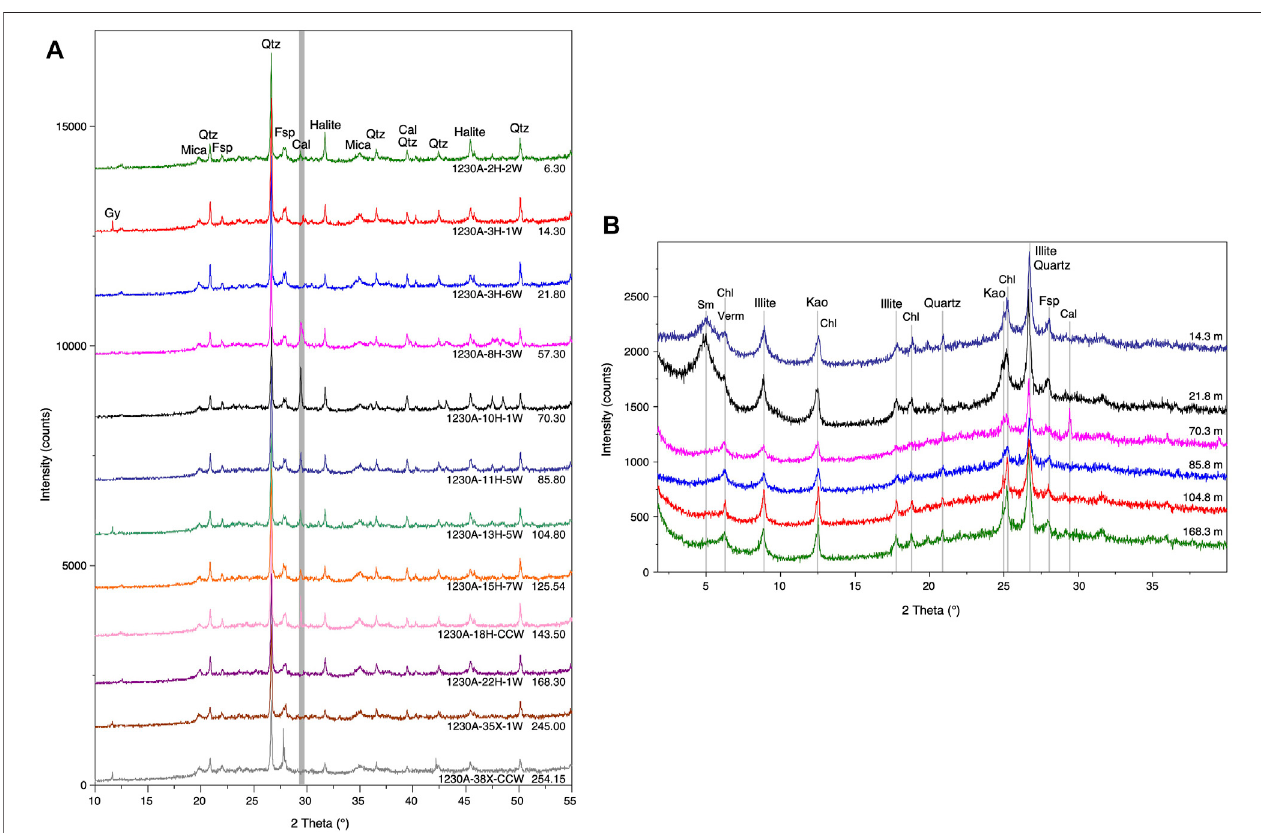
FIGURE 3 | X-ray pattern of analysed sediment samples from ODP Site 1230. (A) Bulk sediment showing quartz (Qtz), feldspar (Fsp), mica, and calcite (Cal). The spectra are arranged in the sequence as they occur through the drilled core. Halite and gypsum (Gy) usually form due to evaporation during sample storage. (B) X-ray patternsofMg-glycerolsaturatedclayfractions,arrangedinthesamesequenceastheyoccurthroughthedrilledcore.Thespectrawereinterpreted toindicatesmectite (Sm), vermiculite (Verm), chlorite (Chl), kaolinite (Kao), and illite, based on comparison of spectra from the fractions treated with Mg-ions, K-saturated fractions treated with ethylene glycol, and fractions heated to 550 ° C (shown for sample 21.8 mbsf; Supplementary Material ).